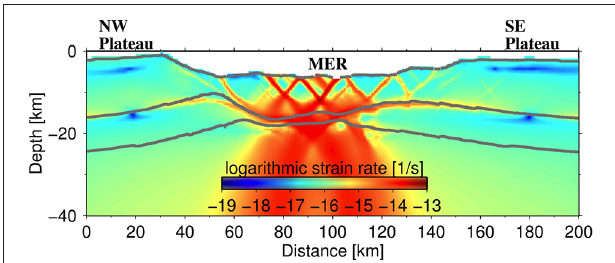
FIGURE 3 | Present day 2D strain rate in the MER and adjacent plateau (from Muluneh et al., 2020). In the MER, high strain rate is localized in ∼ 30 km wide